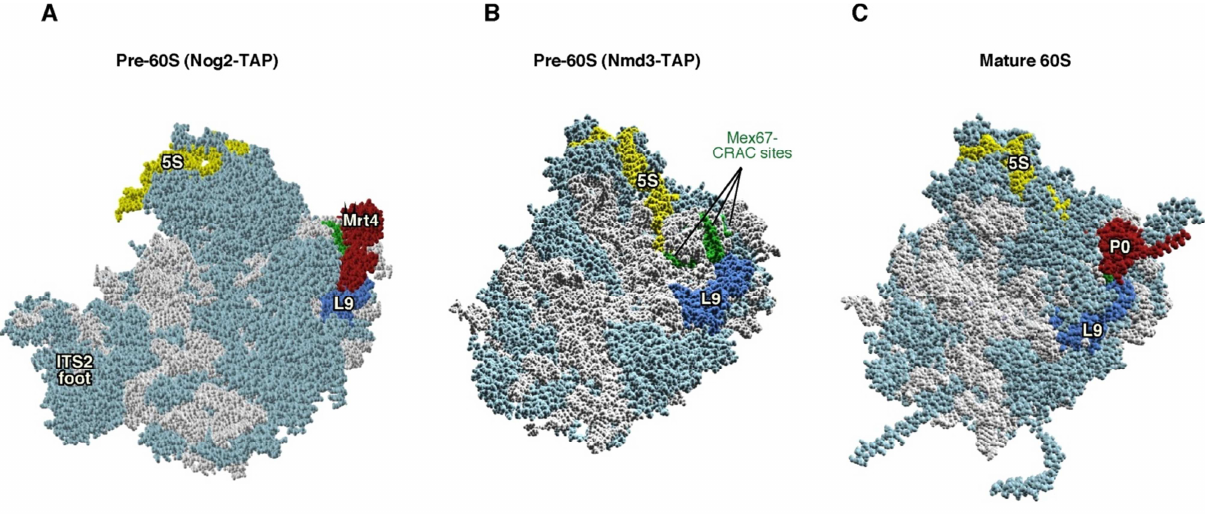
Figure 1: Mrt4 and Mex67 act as placeholder factors for the P0 r-protein. (A) Position of Mrt4 (red) in the early pre-60S r-particles purified with Nog2-TAP (PDB ID: 3JCT; [40]). (B) Mex67-binding sites at the P0 neighbourhood (green), identified by CRAC [42], have been highlighted in the late/cytoplasmic Nmd3-TAP pre-60S r-particle (PDB ID: 5H4P; [43]. (C) Position of P0 (red) in the mature 60S r-subunit (PDB ID: 3U5I, 3U5H; [44]). Particles are viewed from the subunit interface slightly turned to the left. For orientation, the positions of the 5S rRNA (yellow), the L9 r-protein (royal blue) and the above CRAC sites of Mex67 (green) have been highlighted in the three structures. The ITS2 foot has also labelled in A. Note that some of the CRAC sites of Mex67 overlap with Mrt4 and P0 in A and C, respectively. The rest of rRNAs are coloured in pale blue and the rest of r-proteins and/or factors in light cornflower blue. Images were generated using the UCSF Chimera program